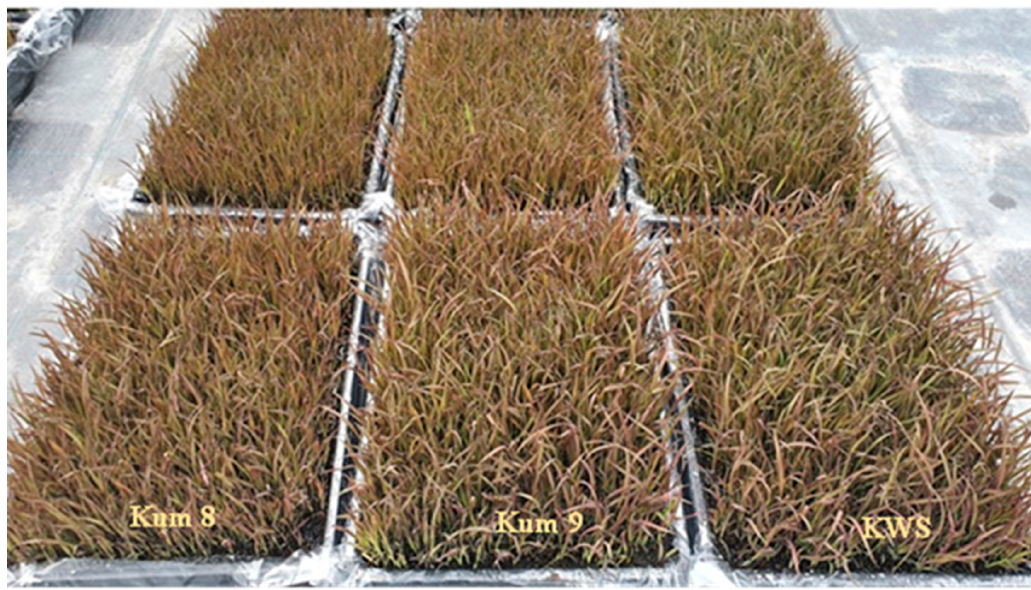
Figure 5. Purple rice seedling of Kum 8, Kum 9 and KWS used in this experiment.